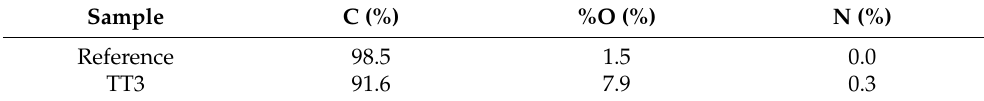
Table 7. Surface elemental composition of the untreated and TT3 graphite felt calculated by XPS.